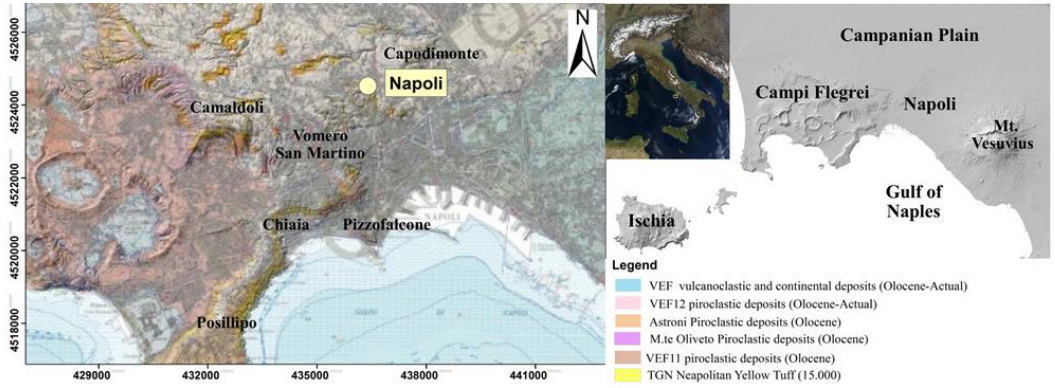
Figure 2. Geological Map of Naples extracted from the Geological Map of Italy, 1:50,000 (Sheet Naples n. 446–447).